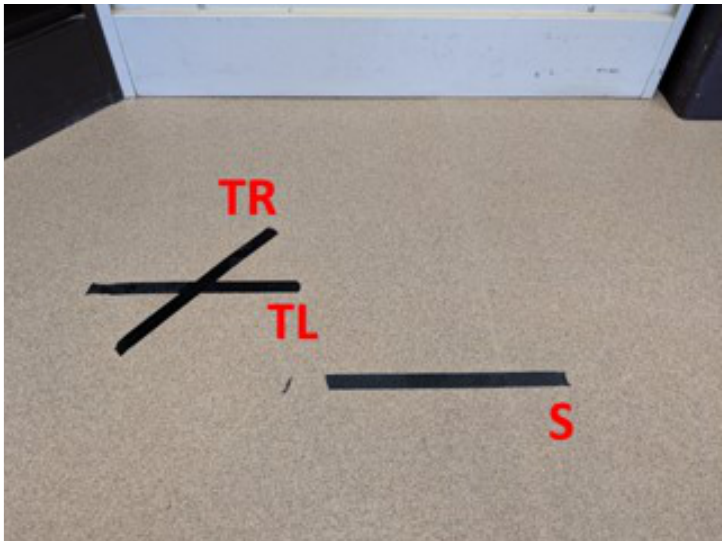
Figure 2. Tape lines on the floor for start/end crate alignment. The tape line marked S is the start/end point for straight lifts and was parallel to and 56 cm away from the main shelf (white). TL was the starting point for lifts in which the participant twisted left while lifting from the floor to the shelf and was parallel to and 42 cm away from the main shelf. TR was the starting point for lifts in which the participant twisted right while lifting from the floor to the shelf and was parallel to and 42 cm away from the secondary shelf